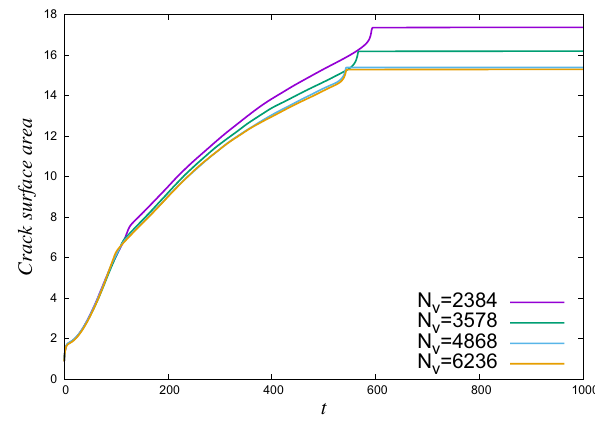
N mesh setting on v a boundary box Fig. 9 Relationship between the number of vertices and the crack surface area